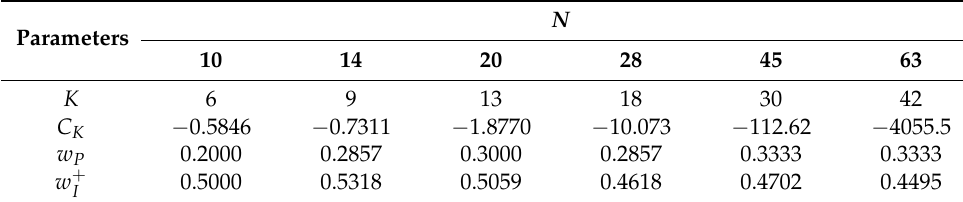
Figure 8. Cut off-frequency fixing filters with various N and ω c = 0.369 π ( w c = 0.4). Table 4. Related parameters of Figure 8. Parameters